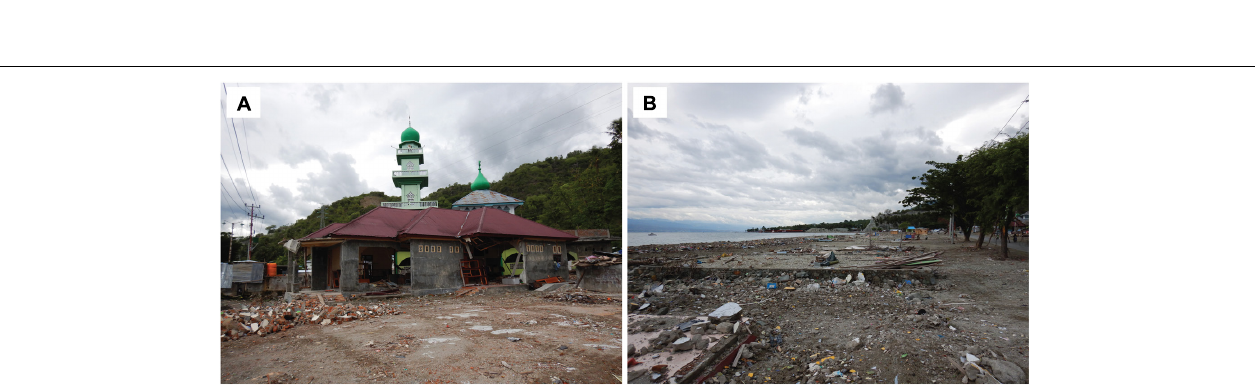
FIGURE 7 | Observed tsunami damage near Donggala port (point 1 in Figure 2 ): (A) damage due to lateral spreading, (B) liquefaction-related foundation failure, and (C,D) damage due to lateral spreading at Pavilion Gonenggati Donggala.